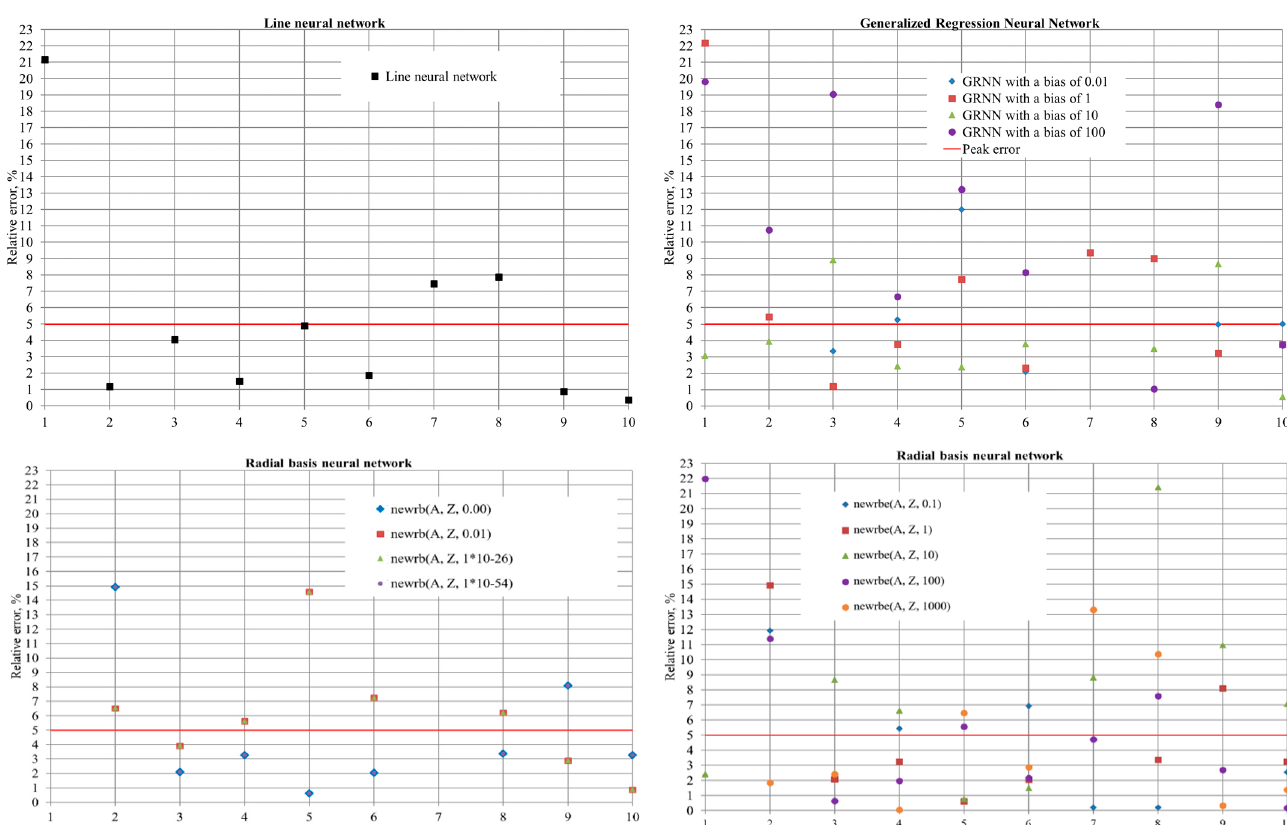
Figure 9. The first approximation of the numerical experiment.